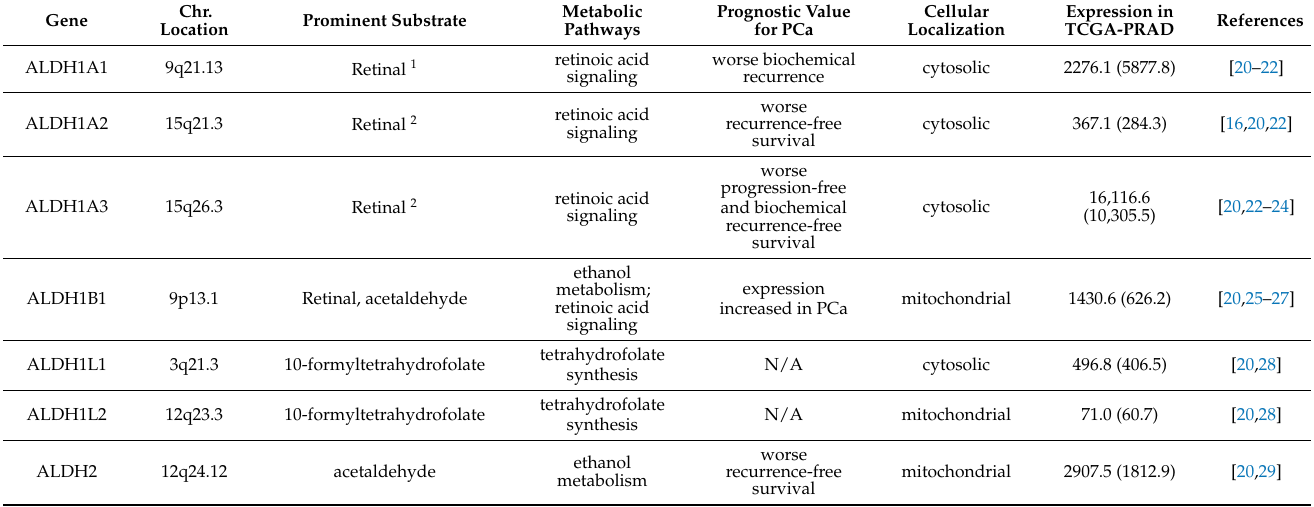
Table 1. Characteristics of the ALDH family genes. Cellular localization and notable substrates have been adapted from Kopakka and colleagues [20] and additional sources. Expression values in the TCGA-PRAD dataset are given as fragments per kilobase of transcript per million mapped reads, FPKM (standard deviation). Isoforms with an expression of less than 16 FPKM in 90% of patients were filtered, and FPKM values were confidence interval corrected across all of the